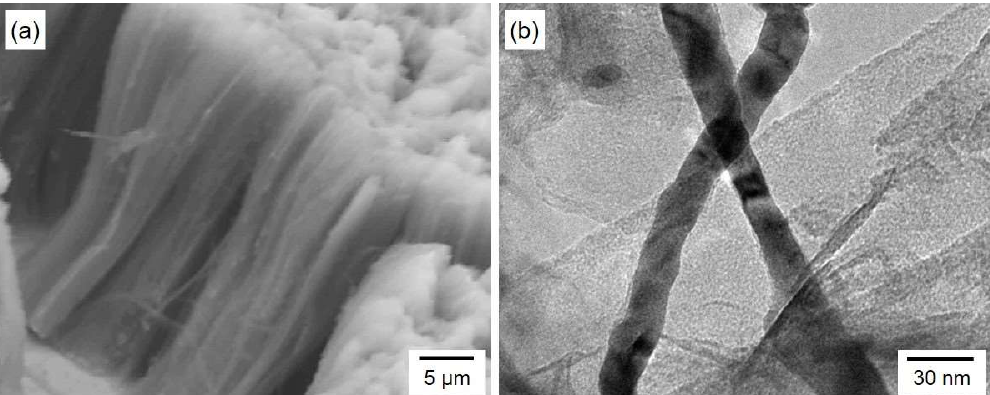
Figure 6. SEM image ( a ) and TEM image ( b ) of Co nanocrystals electrodeposited potentiostatically. Co nanocrystals were separated from an anodized aluminum oxide nanochannel template.